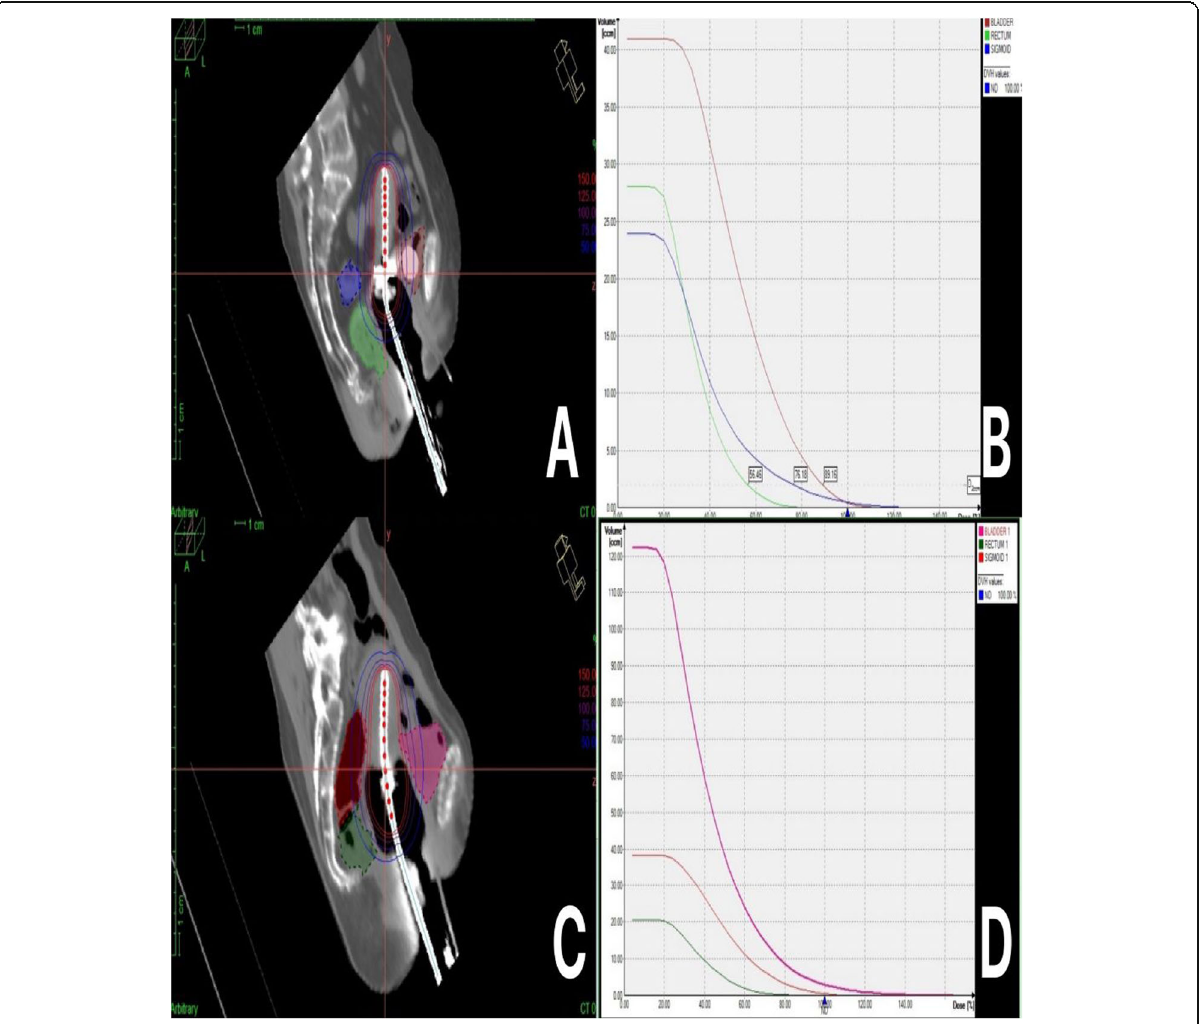
Fig. 1 ( a – d ) Isodose distribution and DVH parameters for OARs in a patient treated under procedural sedation ( a, b ) and under general anaesthesia ( c, d